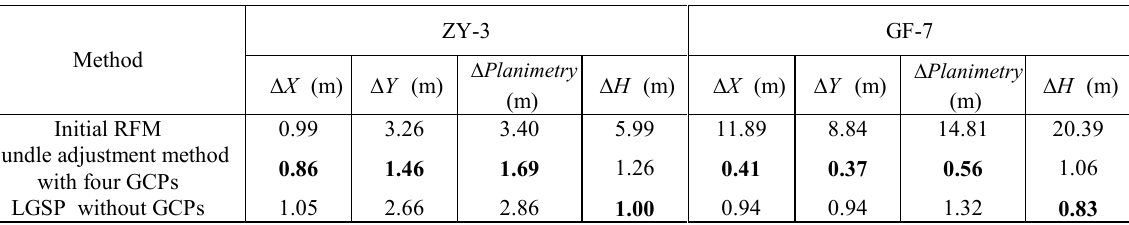
Table 3 . RMSE of methods for processing satellite stereo image